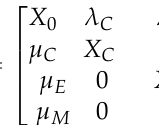
Figure 3. Transition diagram of the EPBM and its subsystem. From the transition diagram, a system transition matrix is formed, and the probability of each subsystem is